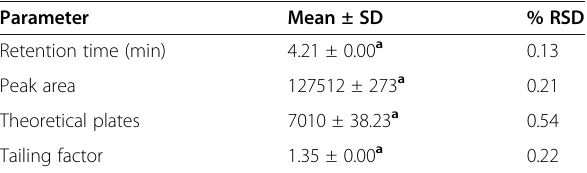
Table 1 Results of system suitability studies of quality control samples of